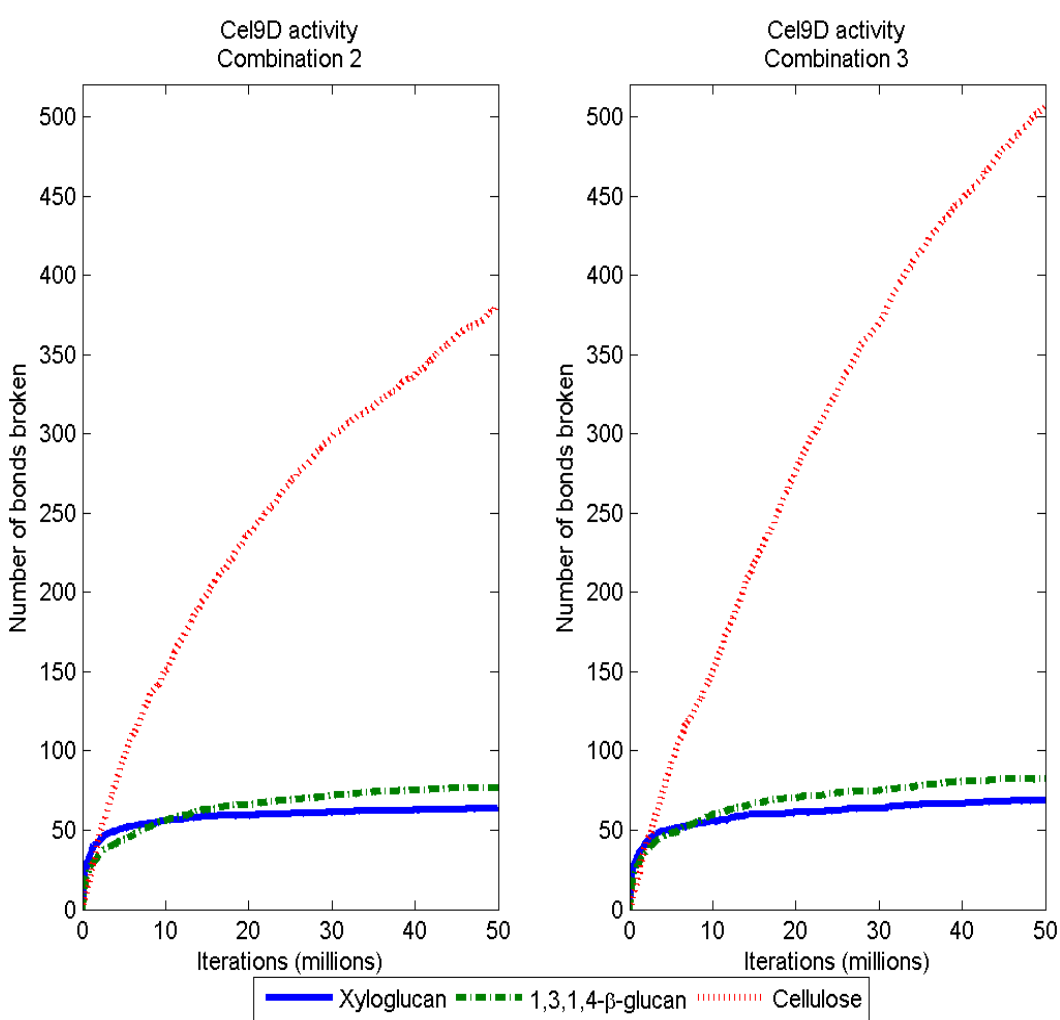
versus simulation progress (in iterations), for two different enzyme